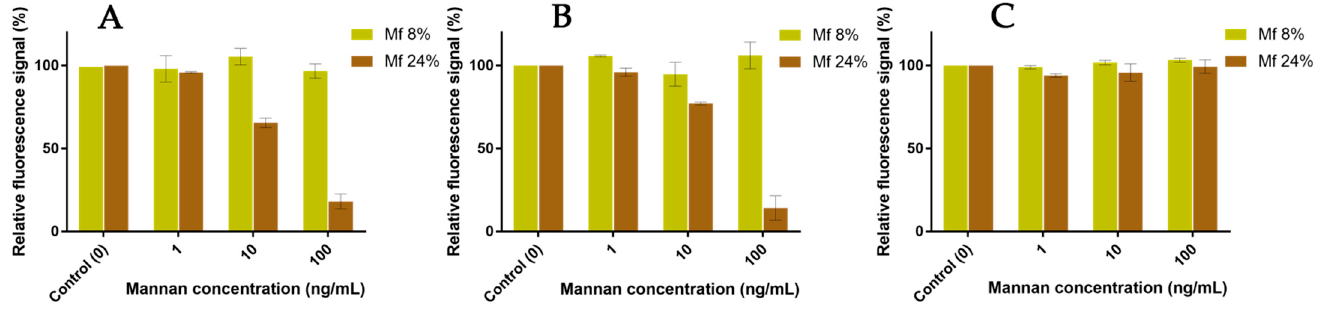
Figure 14. Competition assays of Mf (8% and 24%) bonded to fixed hMBL ( A ), hSP-D ( B ), and pSP-D ( C ) versus Mannan at different concentrations (1, 10, 100 ng/mL).